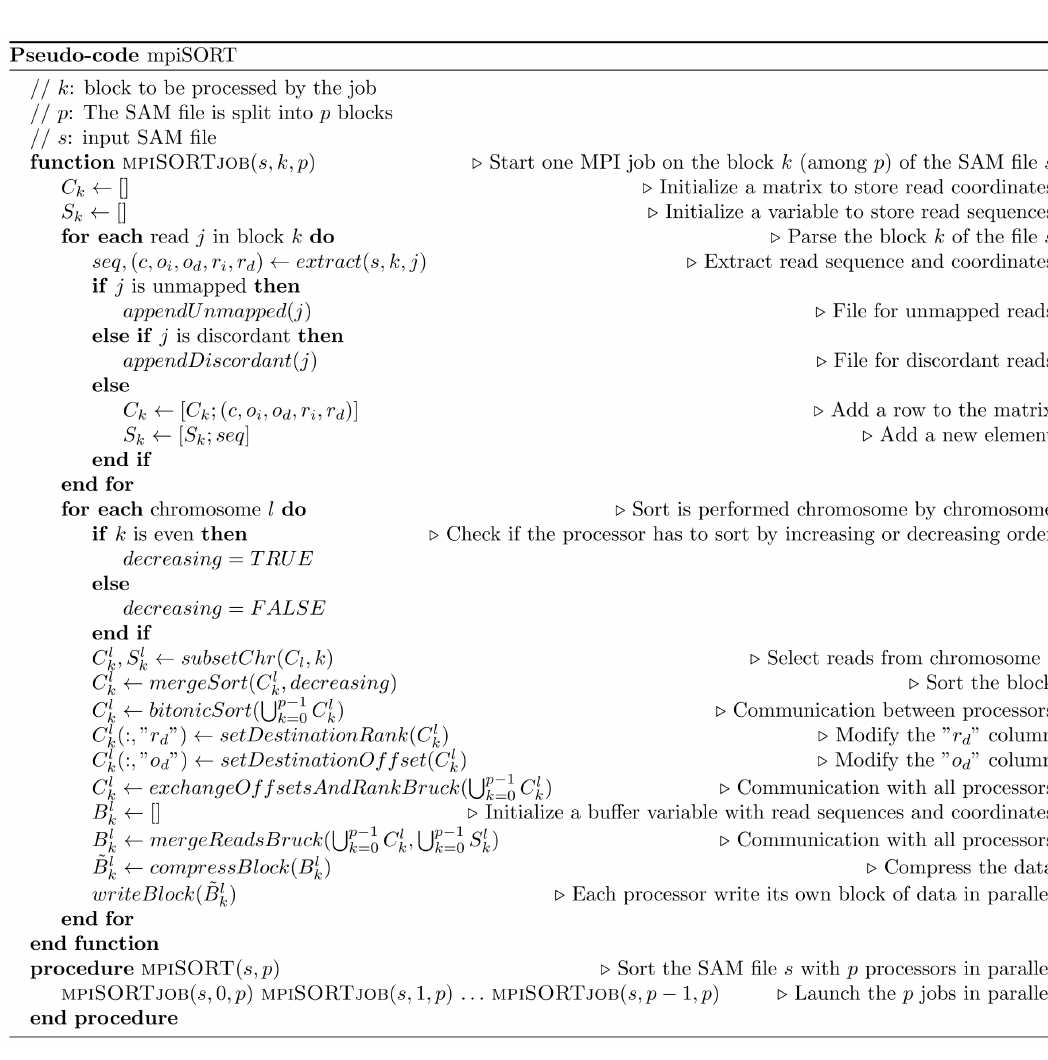
Figure 6. Pseudo-code of the mpiSORT which launches the function mpiSORTjob in parallel over p processors.